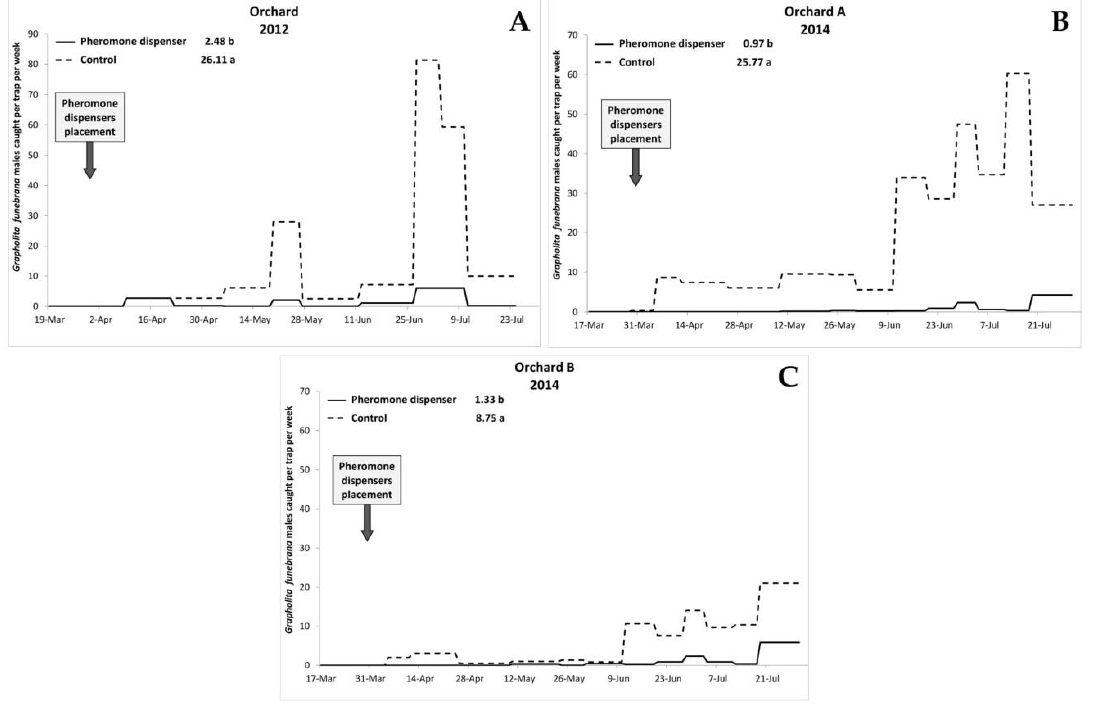
Table 1. Results of the general linear model (GLM) analyses, performed each year separately on the number of Grepholita funebrana males caught in the traps, and effect of the different factors considered (asterisks indicate significant factors within each year, * p < 0.01).